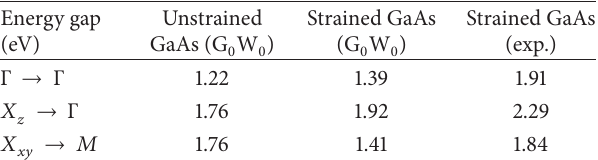
derived from experiment [55, 63] and LDA + G unstrained and strained bulk